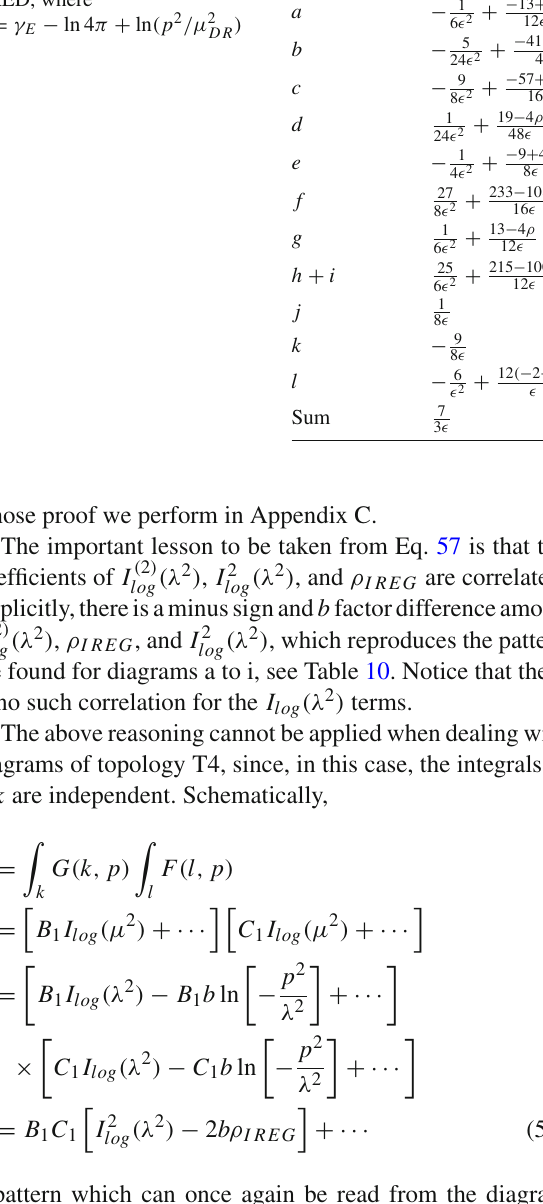
Table 11 Results for pure Yang–Mills using CDR and DRED,